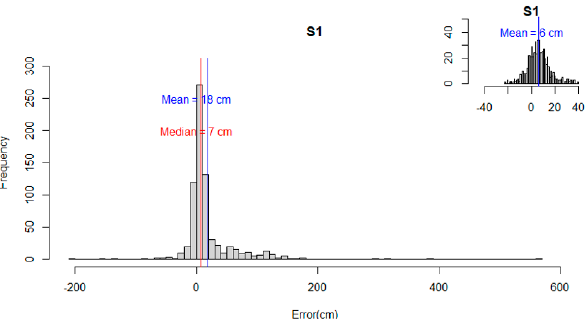
Figure 7. Histogram showing distribution of the difference between S1 for an extent. Inset plot shows data distribution when outliers are removed.